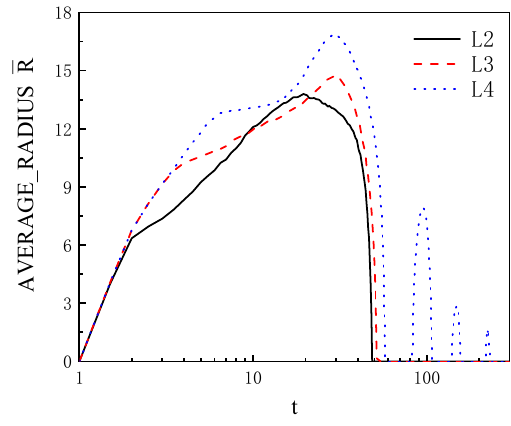
Figure 6. Average bubble radius R with time.